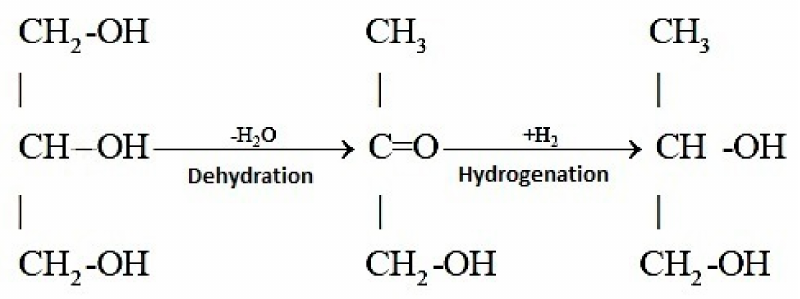
Figure 2. Mechanism of the hydrogenolysis of glycerol to 1,2 propanediol [4].